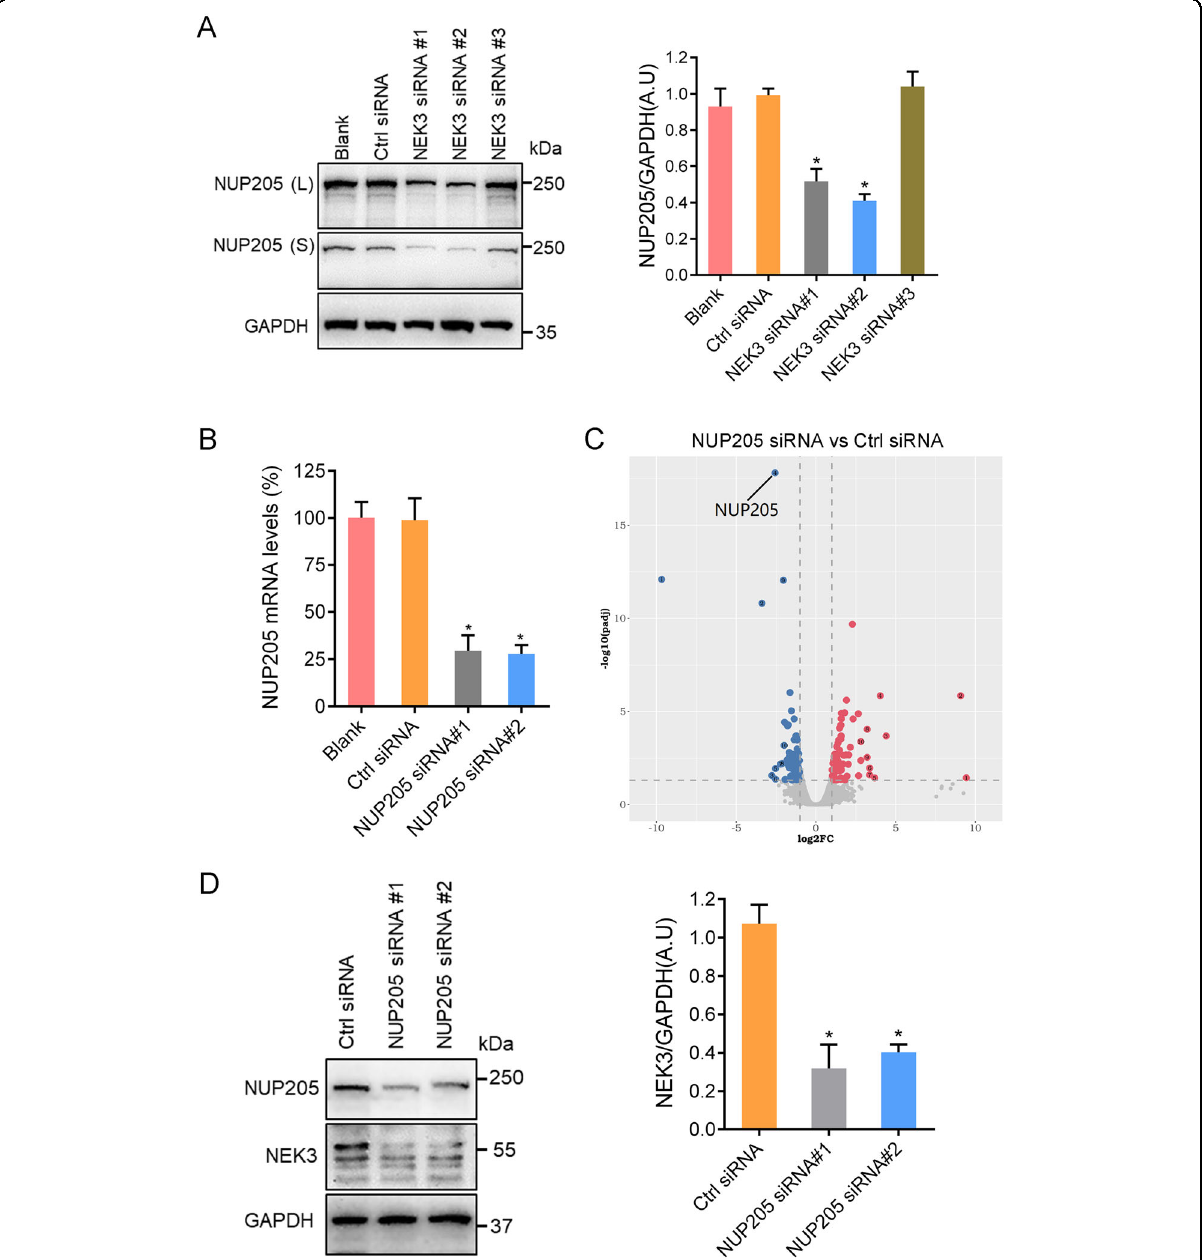
Fig. 6 Reciprocal regulatory interactions between the NEK3 and NUP205. a Western blot showed protein level of NUP205 was downregulated in the NEK3-silenced cells. L long exposure, S short exposure. Right panel: Quanti fi cation data of NUP205 expression level when normalized against GAPDH. * P value<0.05 (Mann – Whitney U test). Representative image from three independent experiments was displayed. b Evaluation of the ef fi ciencies of two siRNAs targeting NUP205 in human RPE cells by real-time qPCR. * p value <0.05 (Mann – Whitney U test, n = 4). c Volcano plots of DEGs ( p value <0.05; fold-change>2) by NUP205 siRNAs mediated silencing in RPE cells when compared with Ctrl siRNA. Up- and downregulated genes are highlighted red and blue, respectively. The plot indicating downregulated NUP205 was highlighted by black line. d Western blot showed that protein levels of NEK3 was compromised by NUP205 knockdown in human RPE cells. GAPDH served as a loading control. Right panel: Quanti fi cation data of NEK3 expression level when normalized against GAPDH. * P value < 0.05 (Mann – Whitney U test). AU arbitrary units. Representative image from three independent experiments was